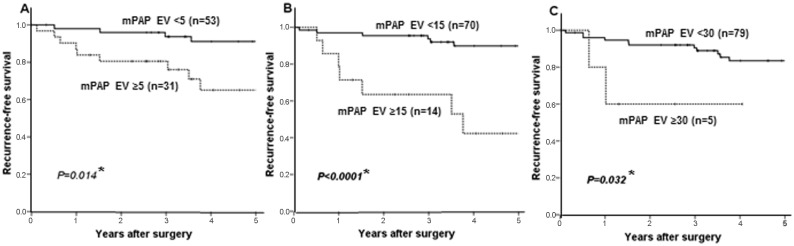
Kaplan-Meier recurrence-free survival curves of the association between the micropapillary (mPAP) estimated volume (EV) and disease recurrence in patients with stage I EGFR-mutated lung adenocarcinomas.A, tumors with mPAP EV of ≥5 versus (vs) those with mPAP EV of <5 (P = 0.014 in the Log-rank test); B, tumors with mPAP EV of ≥15 vs those with mPAP EV of <15 (P<0.0001 in the Log-rank test); C, tumors with mPAP EV of ≥30 vs those with mPAP EV of <30 (P = 0.032 in the Log-rank test); n, number of tumors examined; asterisk(*), statistically significant.